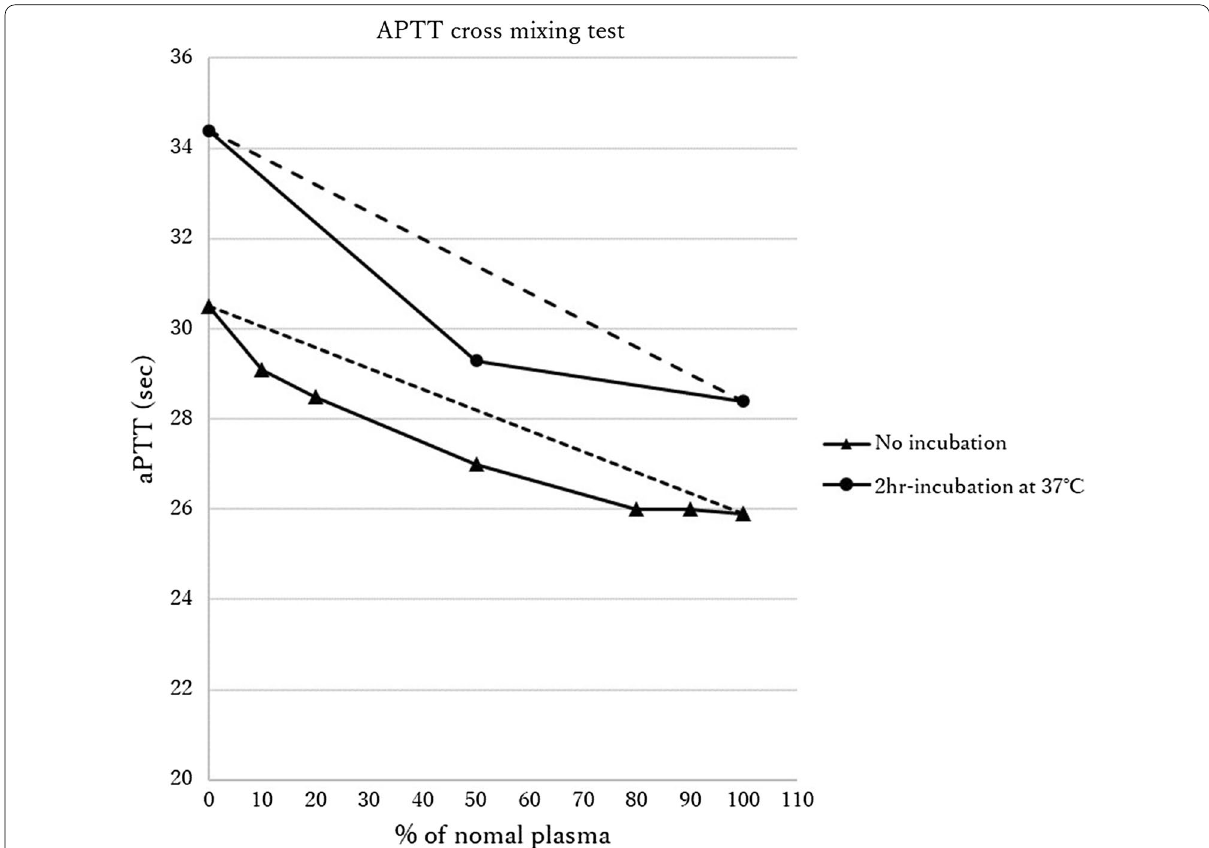
Fig. 1 Results of mixing test. Mixing test detected inhibitor of coagulation factor. A convex upward curve indicates the presence of inhibitors, including coagulation factor-neutralizing antibodies, while a convex downward curve indicates the presence of a factor